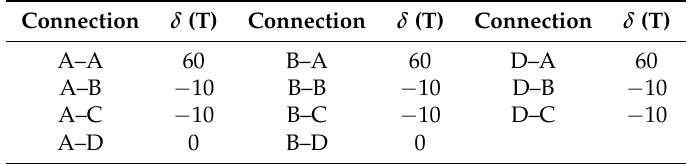
Table 5. Connection differentials for 24 h scheduling horizon solution of BR-S system.